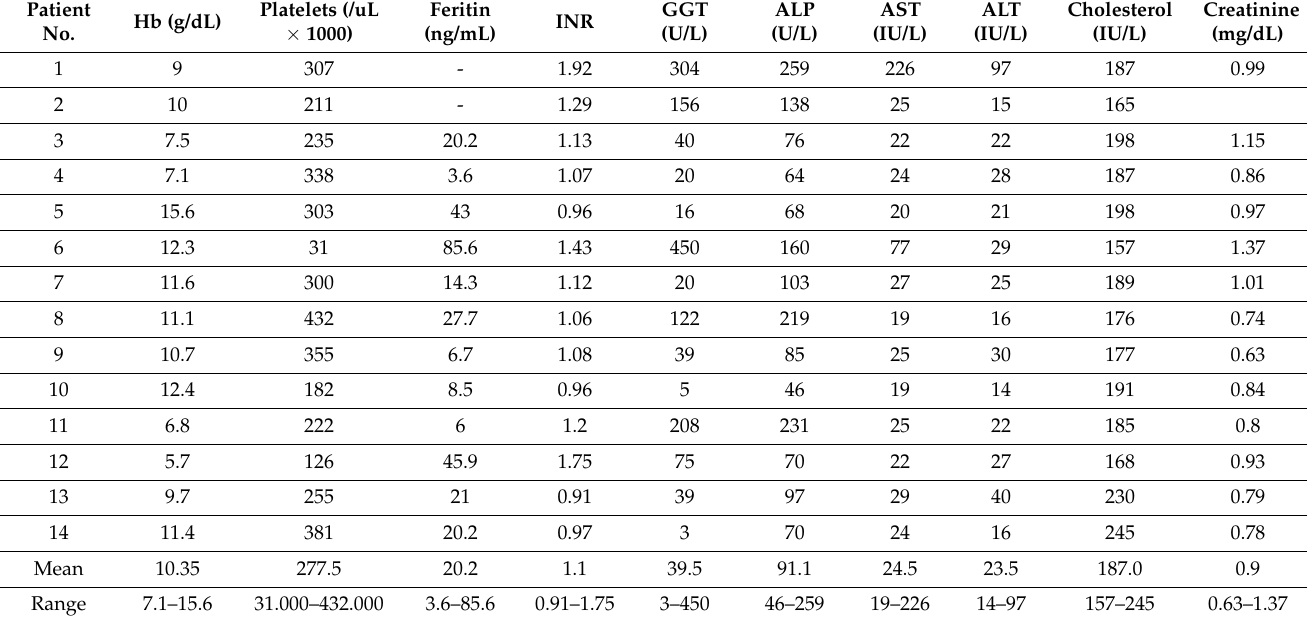
Table 2. The main laboratory findings for each patient with Osler–Weber–Rendu